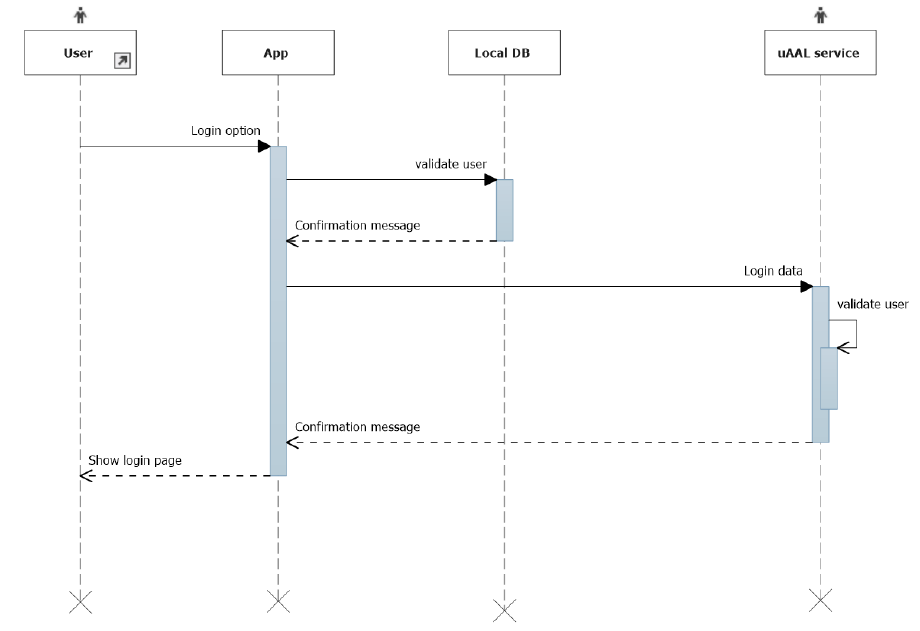
Figure A1. Sequence diagram of the login operation.